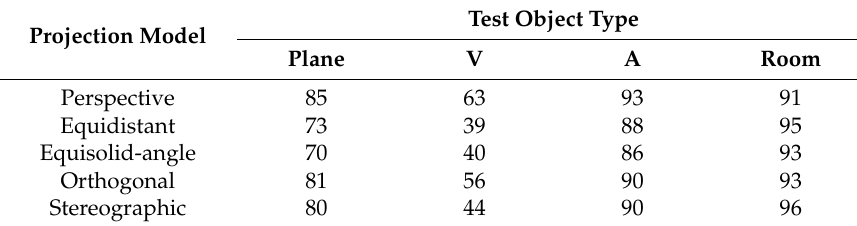
Table 13. Coverage ratio of image points (mean, %).